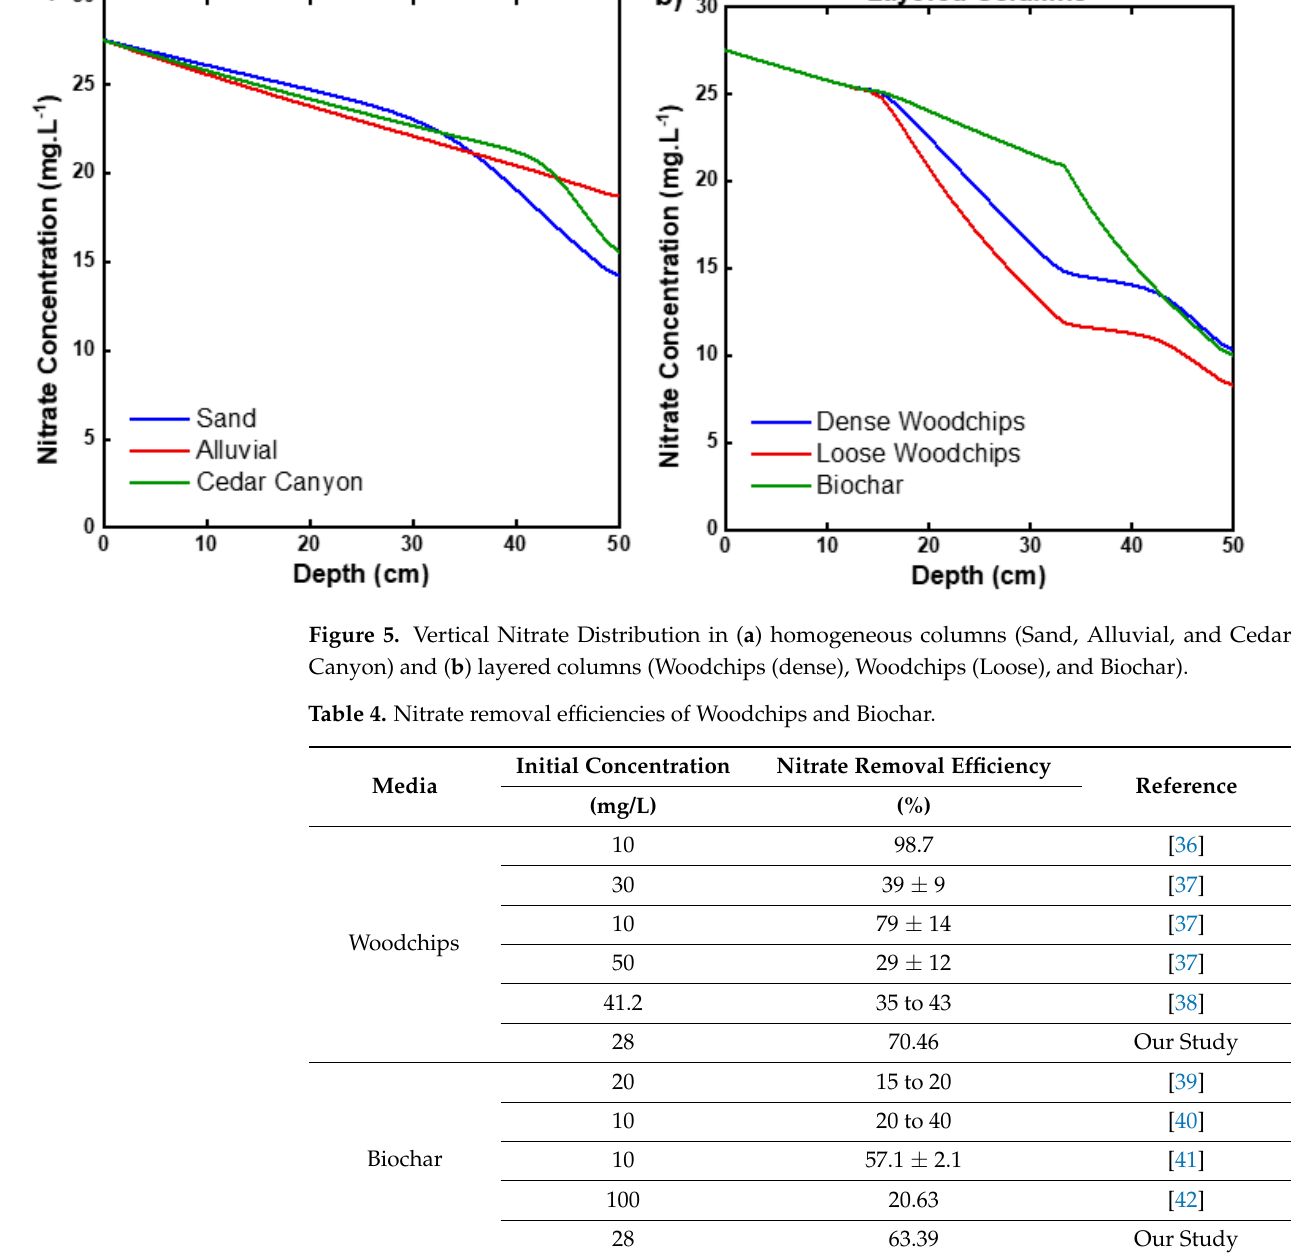
13 Table 4. Nitrate removal efficiencies of Woodchips and Biochar. Media